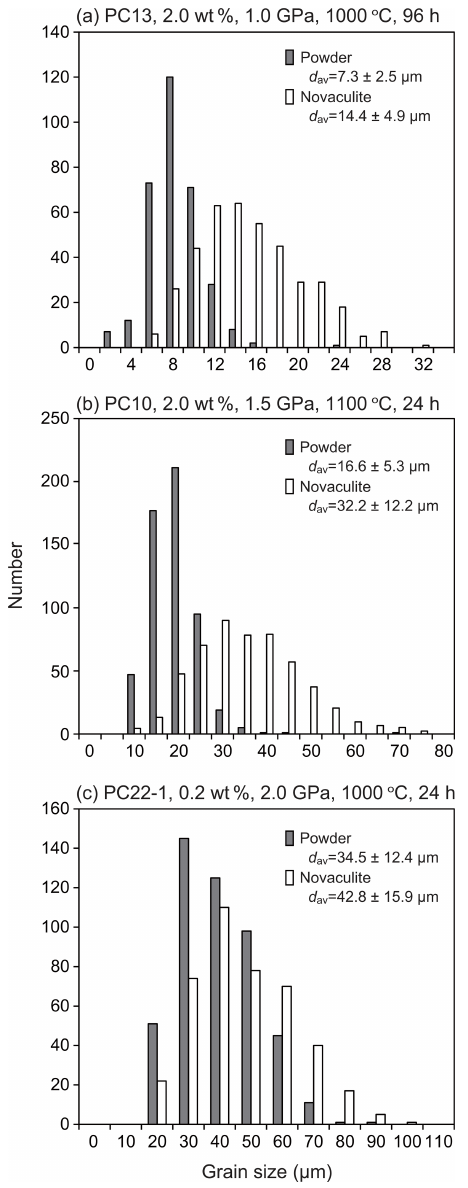
Figure 5. Examples of grain size analyses for ( a ) small, ( b ) medium, and ( c ) large grain sizes in our experimental series.